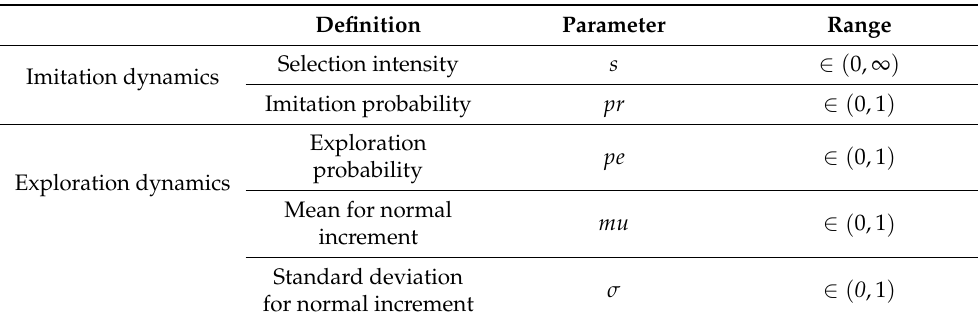
Table 7. Imitation and exploration of parameter values.